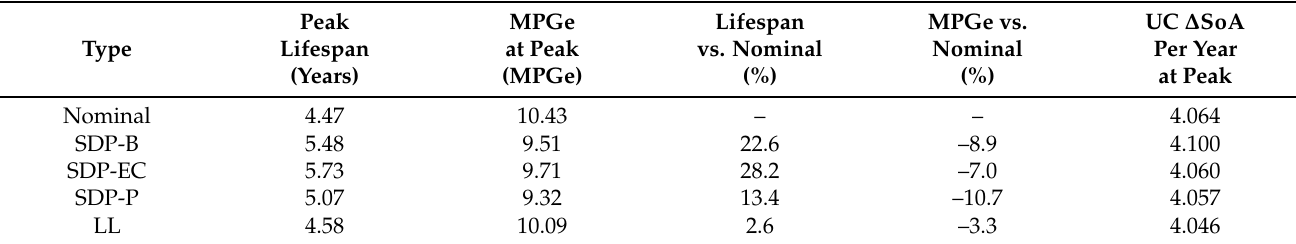
Table 7. Comparison of Causal Controllers, large HESS ( N pc =